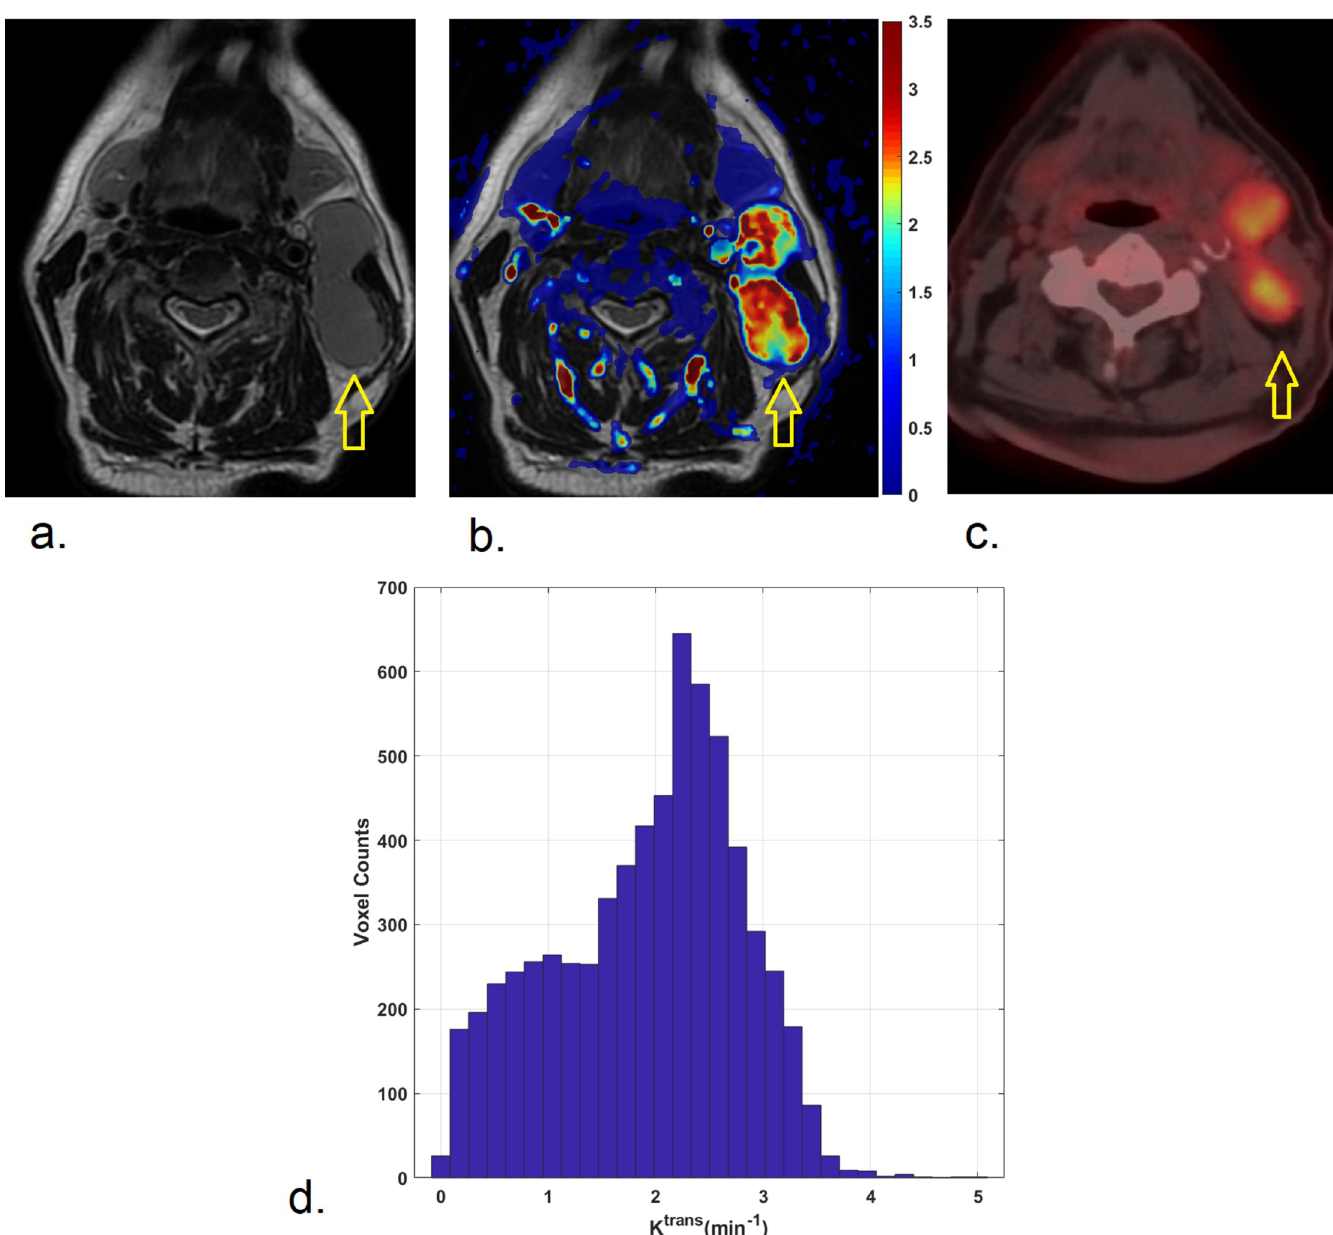
Fig 2. 72-year-old man affected by HPV-positive oropharyngeal squamous cell carcinoma of the base of the tongue with enlarged metastatic lymph-nodes in the left IIa/ IIb level is shown on axial T2-weighted image (a). K trans map (b) indicates high K trans levels in the lymph-nodes, of which the largest posterior node was analyzed, with a median K trans of 2.08 min -1 . Correspondently, a low to intermediate 18 F-FDG uptake (SUV max : 6.09; SUV peak : 5.82; SUV mean : 4.2), was found, as illustrated in 18 F-FDG PET/CT image (c). Histogram of K trans values within the entire lymph node is shown